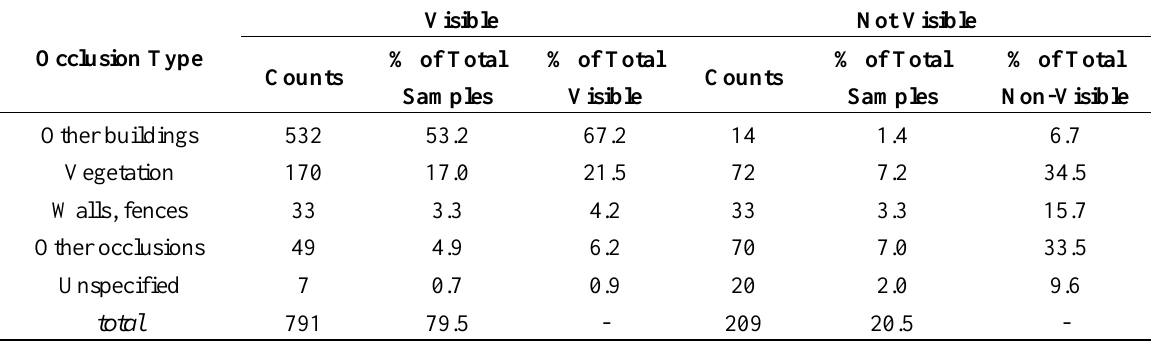
Table 5. Results of occlusion analysis performed on a random sampling of 996 buildings within the viewshed around the survey